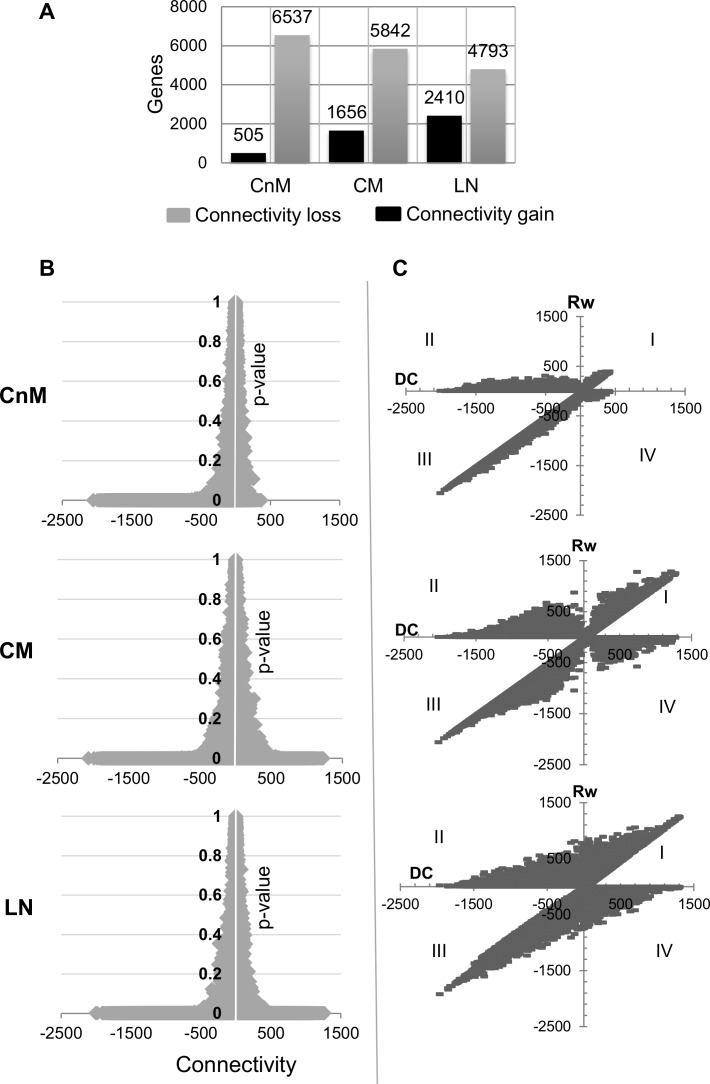
A. Number of genes significantly differentially connected (DC; either loss or gain) in each tumor stage with respect to the normal stage network. B. For each gene DC is plotted with its statistical significance (FDR adj.p-value) and with disease progression, number of genes with increased network connectivity increases under the significant p-value (p < 0.01) as revealed by horizontal line on the positive x-axis. C. For each gene, the calculated gained co-expression (Rw) is plotted with its overall DC score. The graph explains that with disease progression, genes tends to intensify the alterations in the connection types by gaining as well as loosing connections which may or may not alter its DC. Four quadrants suggest that genes may gain novel edges with increased DC (quadrant I) or gain novel connection despite losing overall DC (quadrant II) or lose edges with decreased DC (quadrant III) or show increased DC despite losing connections (quadrant IV). In the graph single gene was plotted two times to correlate Rw (+ve) versus DC and Rw (-ve) versus DC as both of the terms were found to be independent.